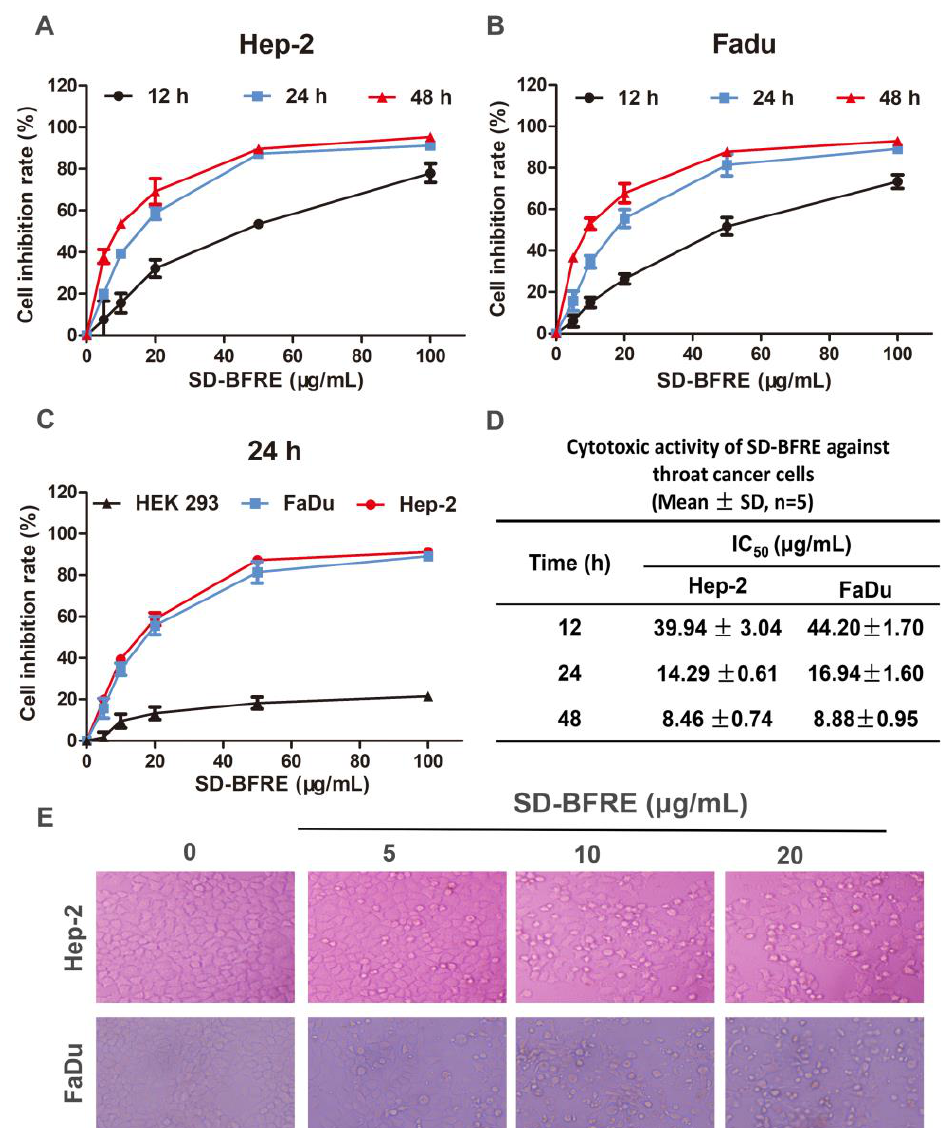
Figure 2. SD-BFRE inhibits cell viability and alters cell morphology in TC cells. ( A , B ) Cell inhibition rate of Hep-2 and FaDu cells after they were respectively incubated at different concentration gradients of SD-BFRE for 12 h, 24 h or 48 h. ( C , D ) Cell viability and IC 50 of Hep-2, FaDu and HEK 293 cells after they were respectively treated with different concentration gradients of SD-BFRE for 24 h. ( E ) Morphological observation of two TC cells lines after the treatment of SD-BFRE for 24 h.